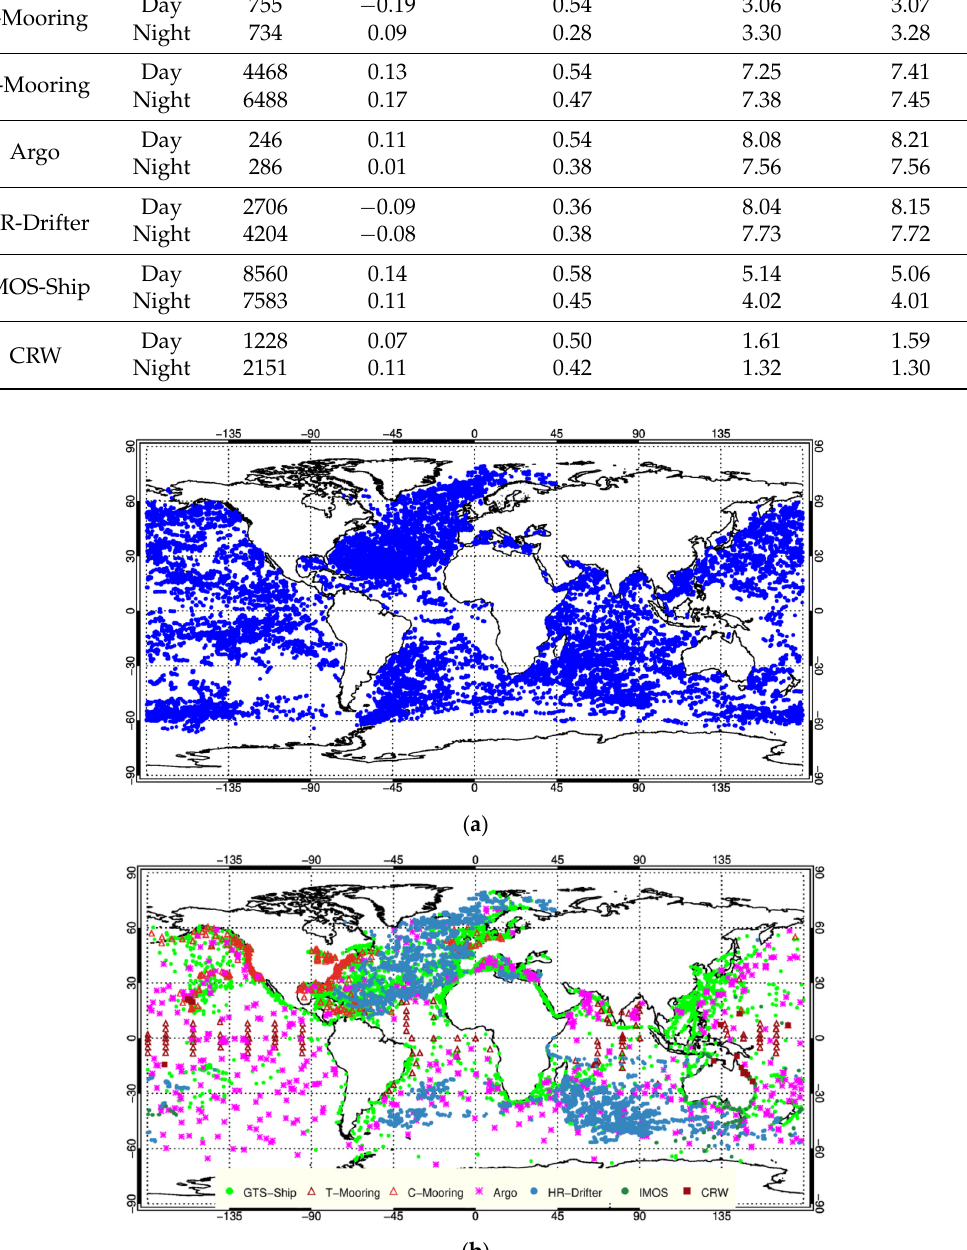
Figure 1. Distribution of NAVO S-NPP VIIRS- in situ matchups during 2014: ( a ) GTS-Drifter (Conventional drifters from GTS) measurements; ( b ) other types of measurements (GTS-Ship: conventional ships from GTS, T-Mooring: Tropical Moorings, C-Mooring: Coastal Moorings, Argo: Argo floats, HR-Drifter: High resolution drifters, IMOS: IMOS ships, CRW: Coral Reef Watch).